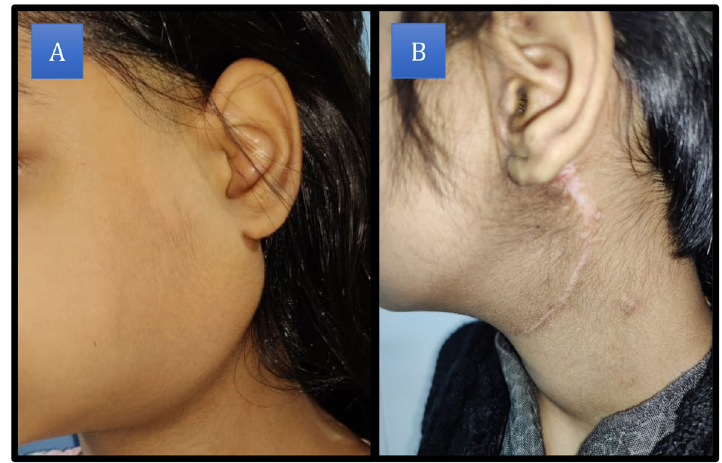
Fig. 2 Neck examination showing swelling below the left ear preoperatively A , and scar three weeks postoperatively